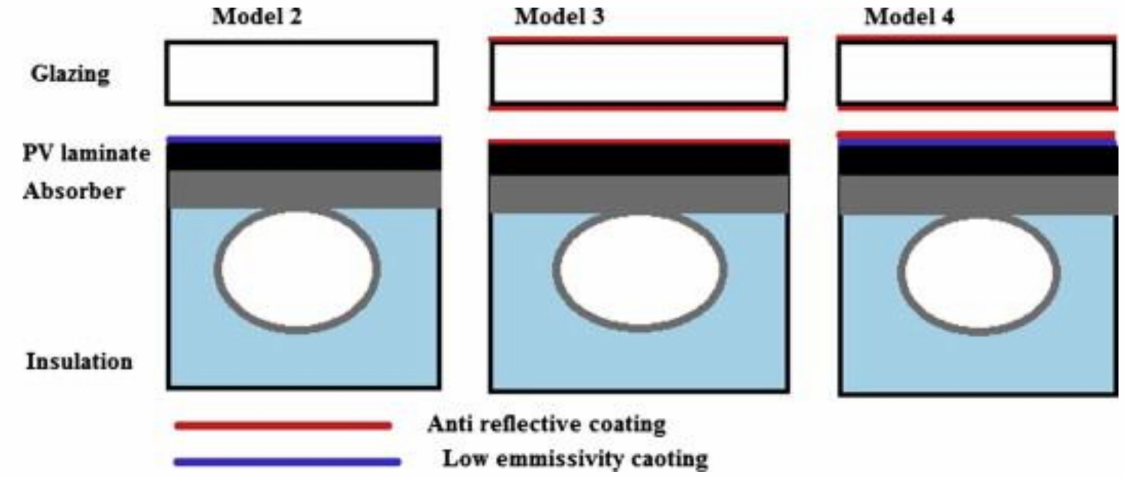
Figure 18. Different configurations of PVT plate (reprinted from [108], with permission from